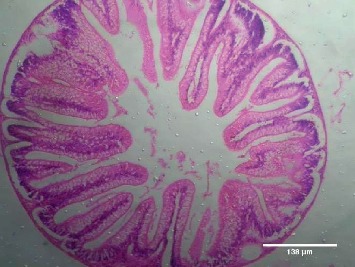
Control-intestine.